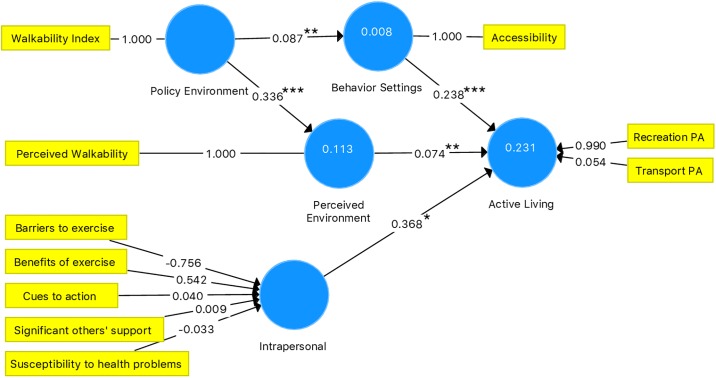
A path model of active living.